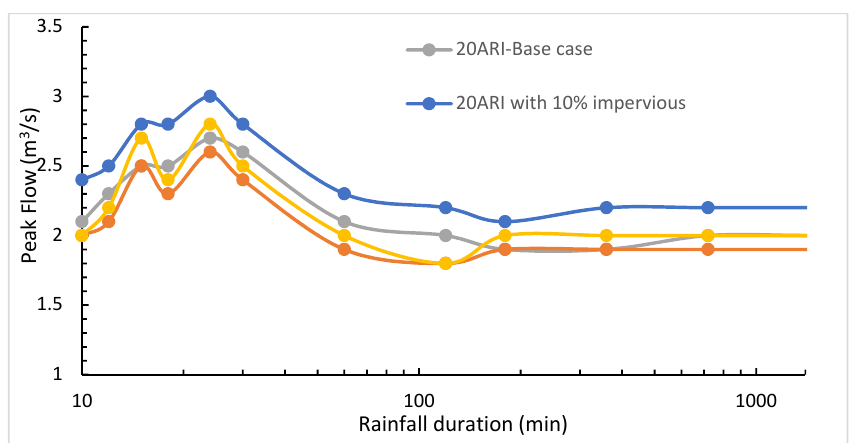
Figure 8. Discharges for 20 year ARI events with 10% increase in imperviousness and significant clogging of permeable pavements.